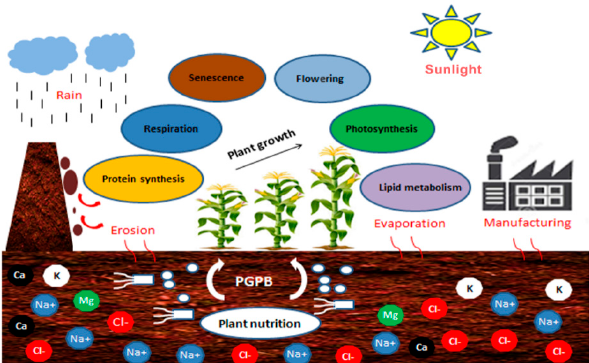
Figure 1. Origin of salinity in the soil and the main impacts of salicylic acid produced by PGPB (plant growth promoting bacteria) on plant primary metabolism.